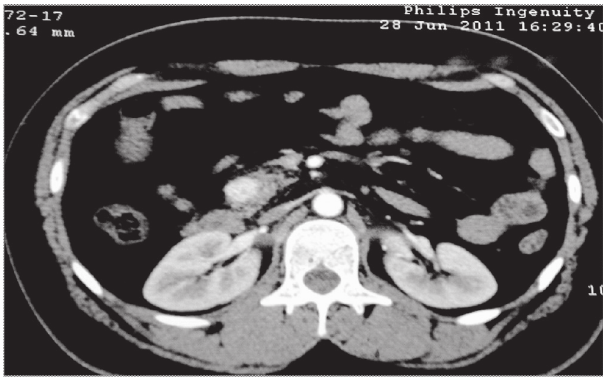
Figure 2. Contrast enhanced CT (transverse section) revealed a solitary insulinoma in the head of